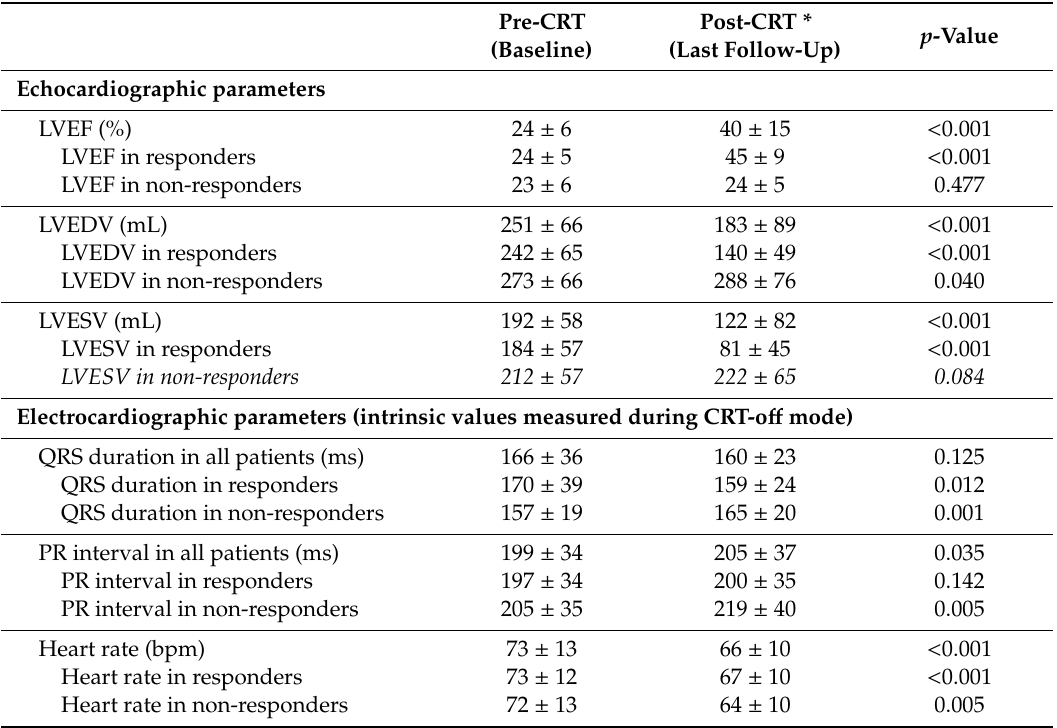
Table 2. Changes in echocardiographic and electrocardiographic parameters.